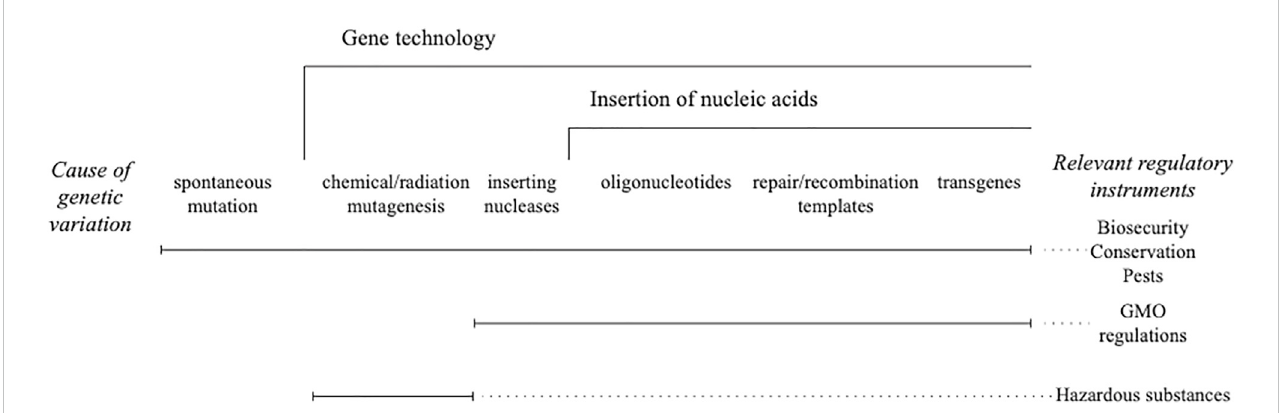
FIGURE 1 Genus risk framework for gene technology. Different legislative instruments are used to control the risk of new combinations of heritable material that are scaled by gene